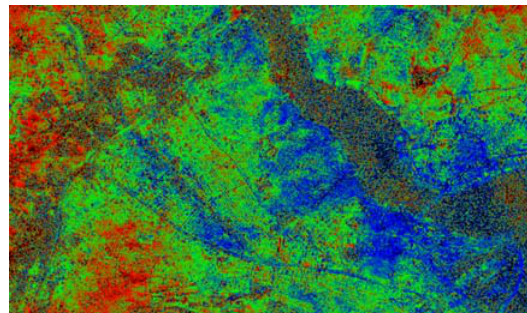
Figure 7. Interferogram of TSX HS images after phase unwrapping